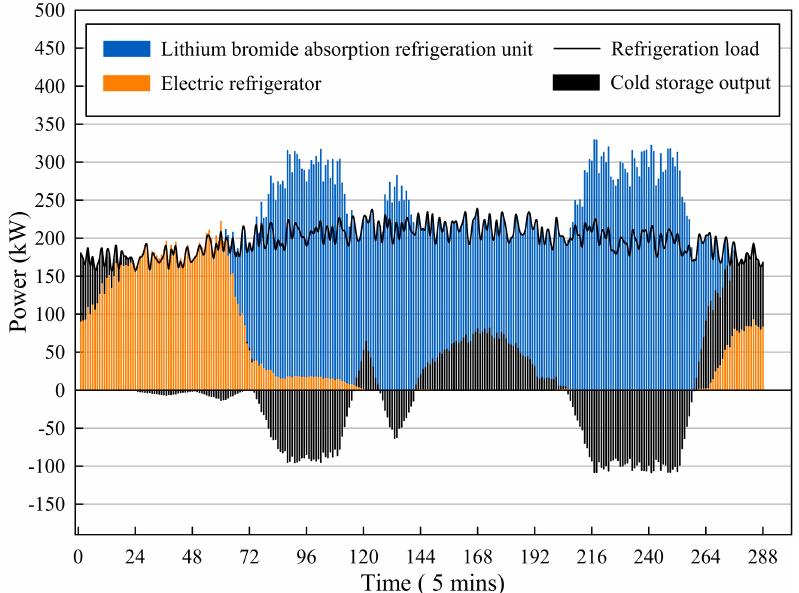
Figure 12. Real-time balance curve of refrigeration load.